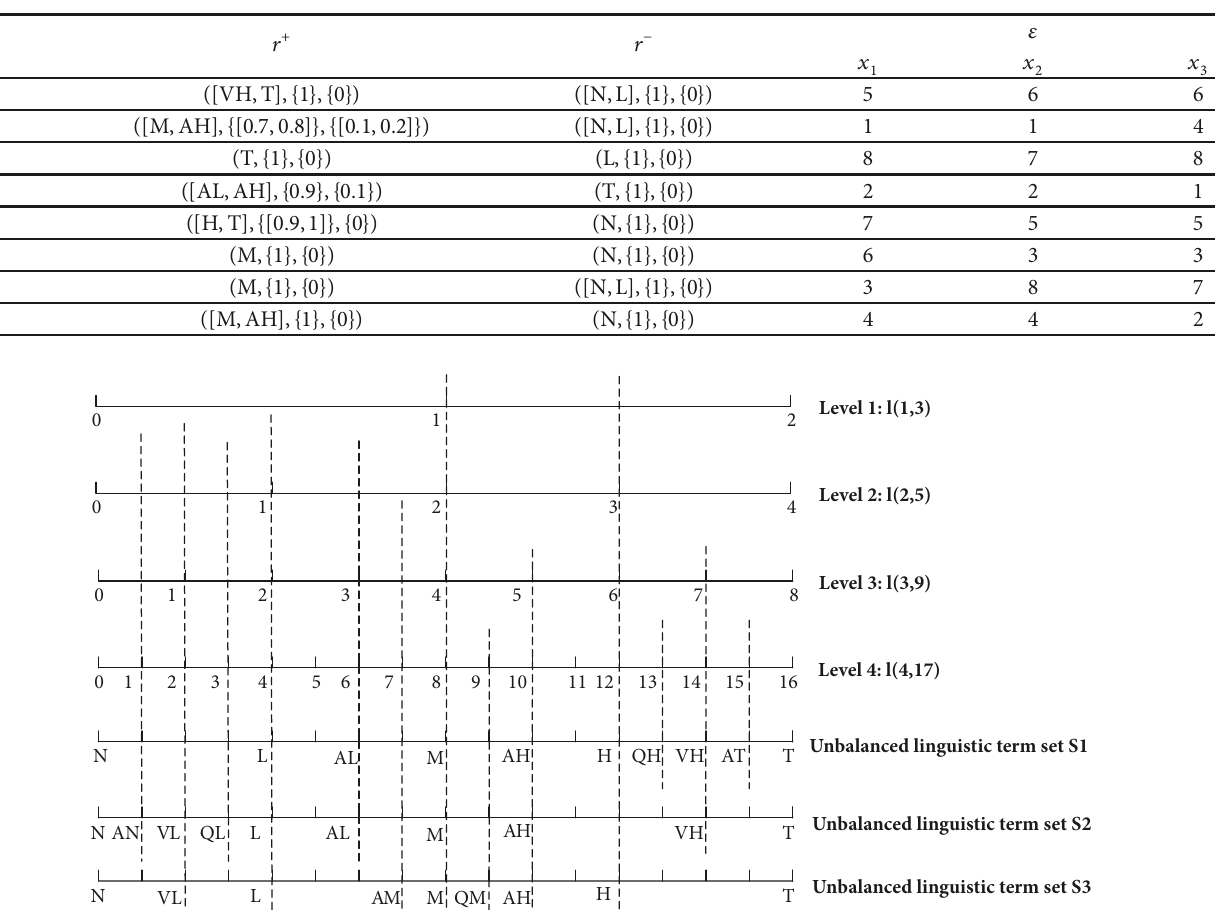
Table 4: Ideal alternatives ( 𝑟 + and 𝑟 − ) and derived order-inducing vectors 𝜀 .